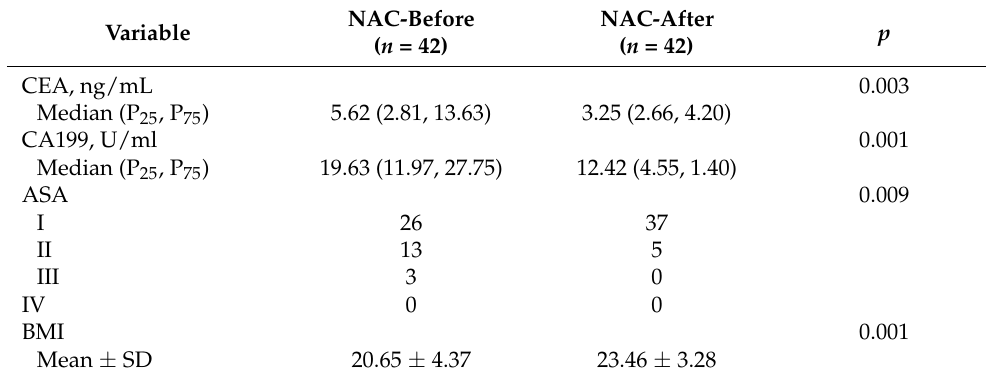
Table 2. Patient characteristics after neoadjuvant chemotherapy for the NAC group.